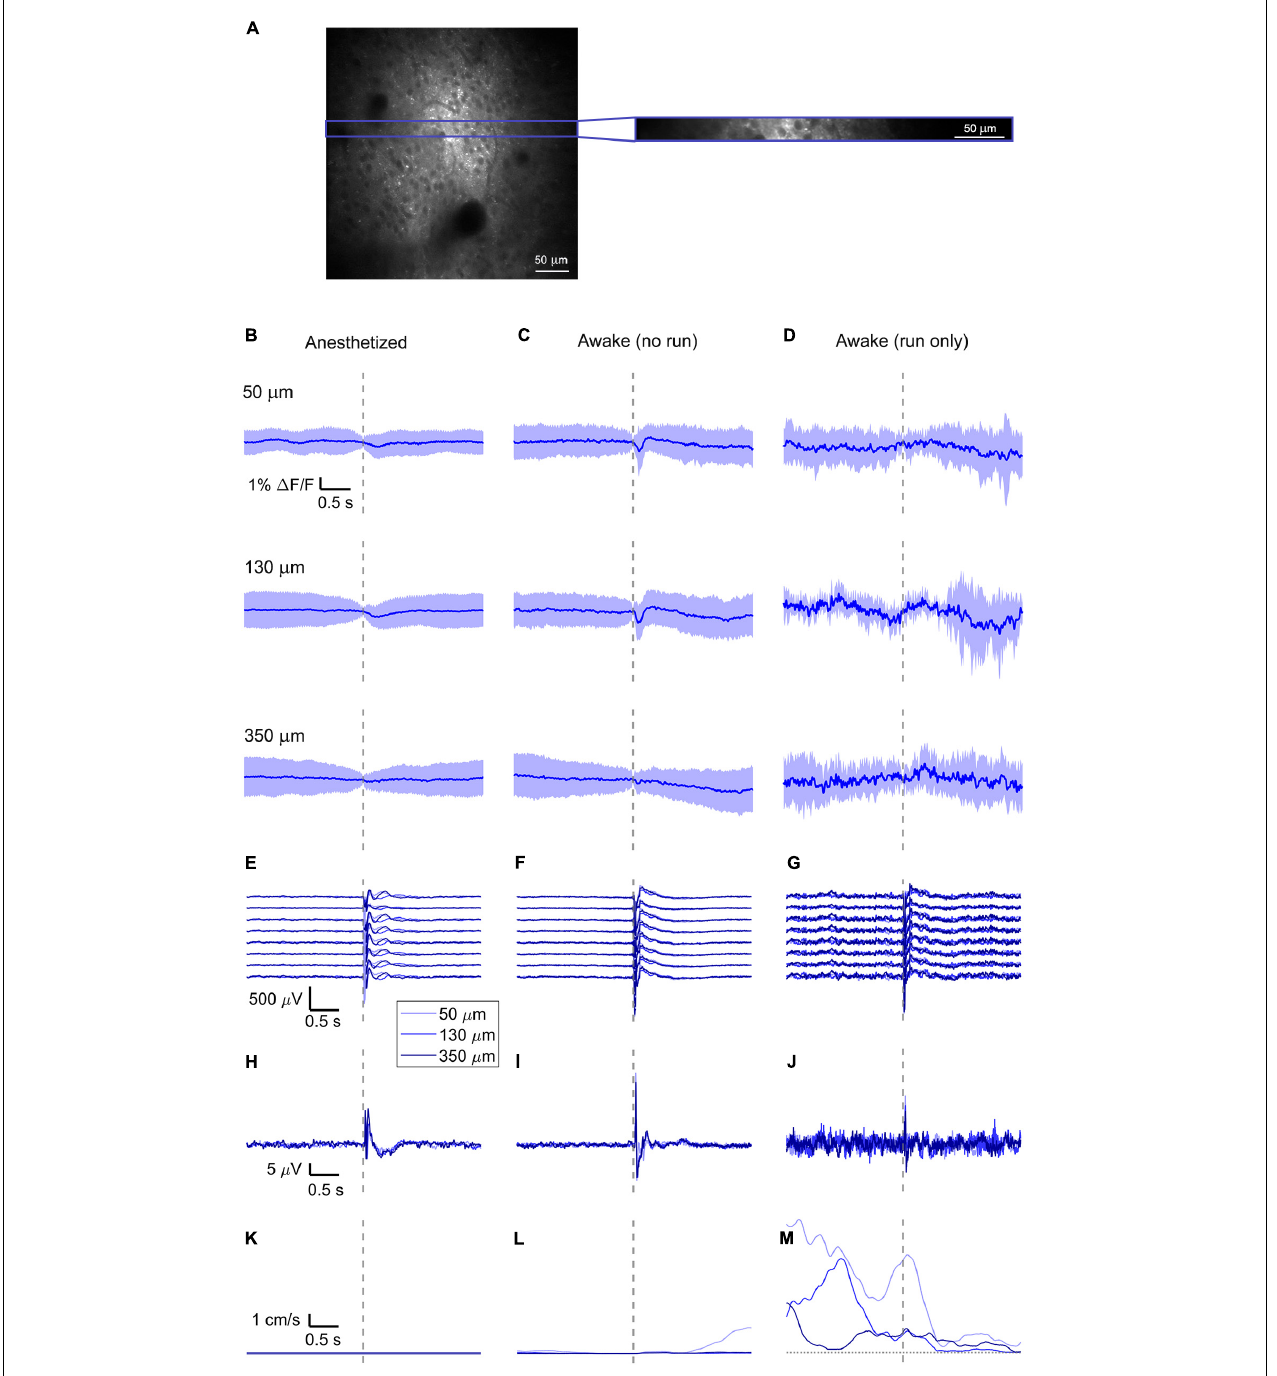
FIGURE 2 | Simultaneously recorded average VSD signal and LFP, both in barrel cortex, ECoG, and running speed in response to a facial air puff (one mouse). (A) A representative imaged cortical region: 375 × 375 µ m 2 full-frame scan and correspondent 375 × 24 µ m 2 box-scan imaged at 130 µ m deep in the cortex. (B–D) VSD responses evoked by an air puff to the vibrissae and cheek of the mouse recorded in 375 × 24 × 5 µ m 3 and 375 × 12 × 5 µ m 3 box-scans from a single mouse at three different depths (B) during anesthesia (50 µ m: 139 trials, 130 µ m: 139 trials, and 350 µ m: 138 trials), (C) in awake mouse during resting (50 µ m: 127 trials; 130 µ m: 125 trials; and 350 µ m: 121 trials), and (D) in awake mouse during running (50 µ m: 7 trials; 130 µ m: 8 trials; and 350 µ m: 12 trials). (E–G) LFP recorded in a single mouse by eight electrodes (every 4th channel of the linear probe, corresponding to a distance of 200 µ m along the probe, (cid:49) depth = 68 µ m between adjacent traces). The probe was inserted with the tip at 850 µ m below the dura. Each channel shown is the average of the same number of trials as for the imaging (light blue at 50 µ m, blue at 130 µ m, and dark blue at 350 µ m). The bottom LFP corresponds to the electrode located 800 µ m below the dura, the top LFP to the electrode located 100 µ m below the dura. Corresponding (H–J) average ECoG and (K–M) average running speed. Dashed gray lines indicate the stimulus onset. All traces are plotted as mean ± standard deviation.